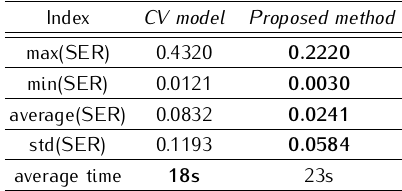
Table 2. Performance comparison of different methods on the E- shaped magnet